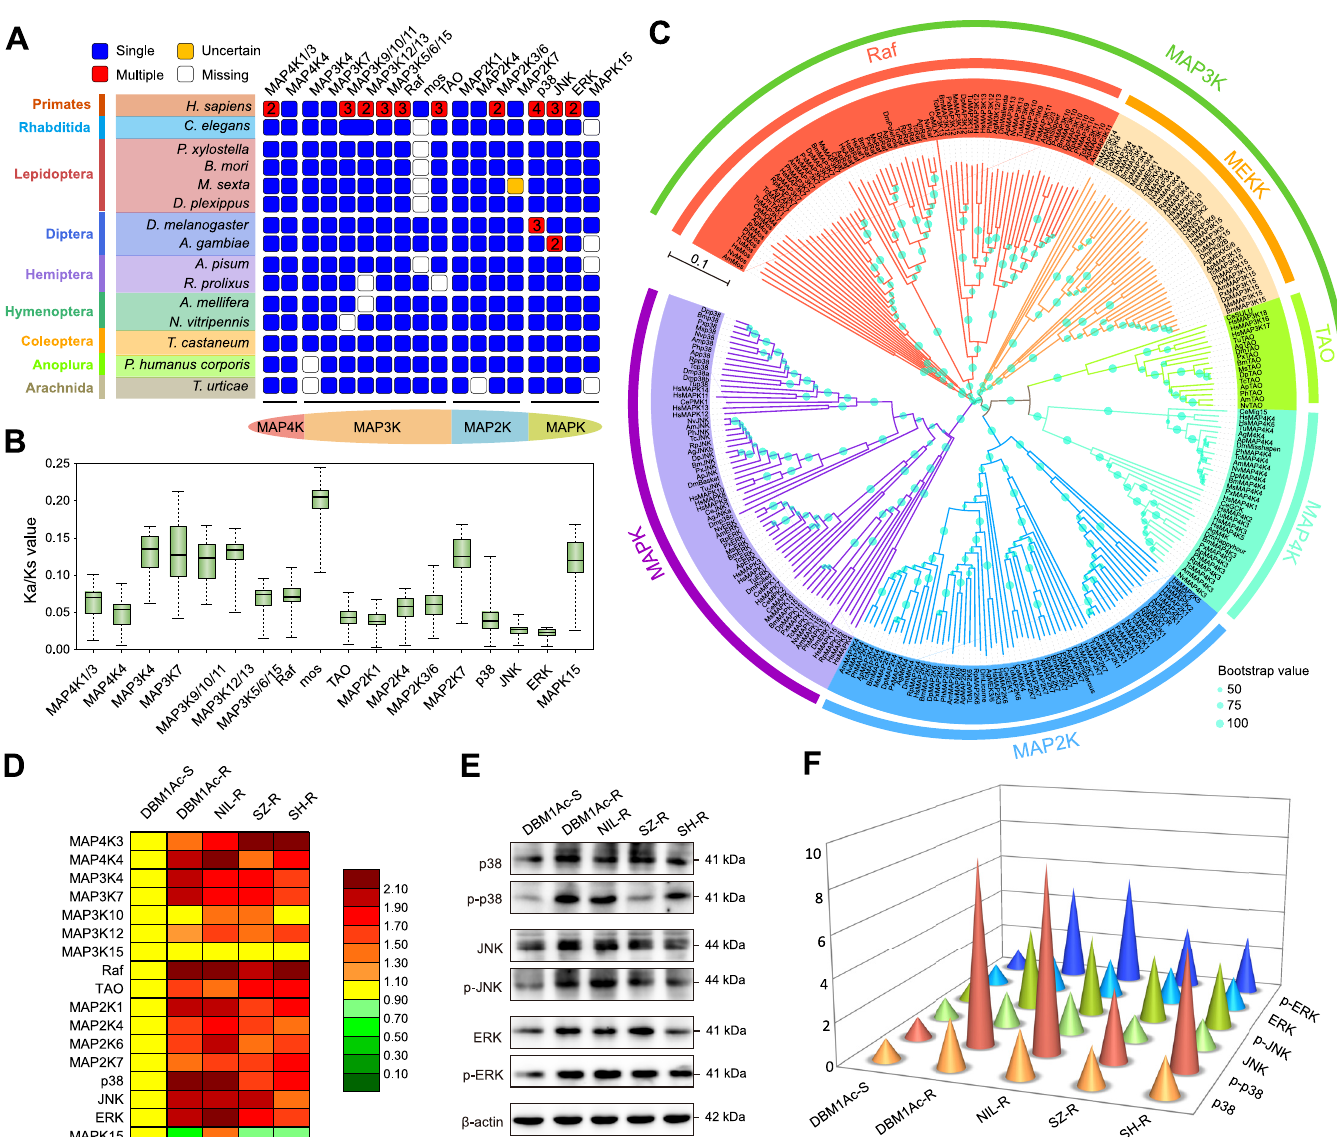
Fig 1. Genome-wide identification and characterization of MAPK cascade genes in P . xylostella . (A) Distribution of MAPK cascade genes among H . sapiens , C . elegans and 13 arthropod species. (B) The Ka/Ks values of MAPKs from 13 arthropod species. (C) Phylogenetic tree of MAPKs from H . sapiens , C . elegans and 13 arthropod species. MAP3Ks include three clades: Raf, MEKK and TAO. (D) Heatmap showing the relative expression levels of MAPK cascade genes in midgut tissues of fourth-instar P . xylostella larvae from the different strains as determined by qPCR analysis. The color of each rectangle denotes the relative expression level of each gene expressed as mean of fold changes relative to the control DBM1Ac-S larvae. Red and green colors indicate up- and down-regulation respectively, while yellow indicates no significant expression variation. (E and F) Western blot analyzes of both total protein and protein phosphorylation levels of p38, JNK and ERK in midgut tissues of fourth-instar larvae from the different strains. The quantification (F) of representative blots (E) using ImageJ 1.51 from three biological replicates is shown. All the control larval samples used in qPCR and western blot analyses (Panels D-F) were without Cry1Ac exposure to quantify the basal expression of MAPK cascade genes.